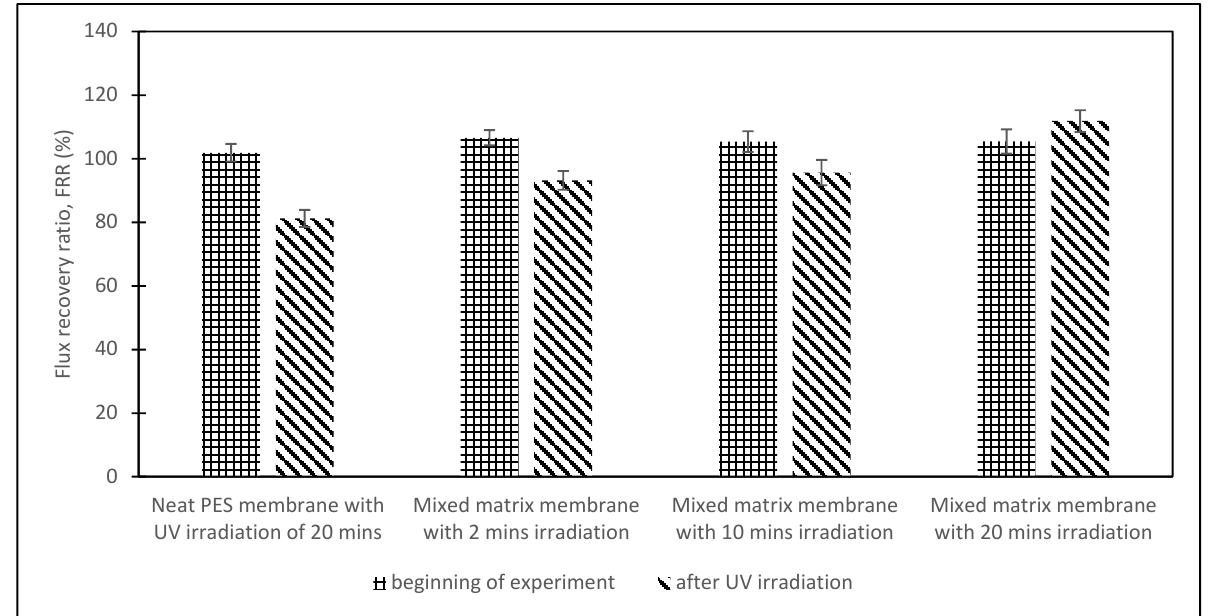
Figure 9. Comparison of FRR among different durations of UV irradiation at the beginning of the experiment and after UV irradiation for a TiO 2 /PES mixed matrix membrane of 3 wt.% .